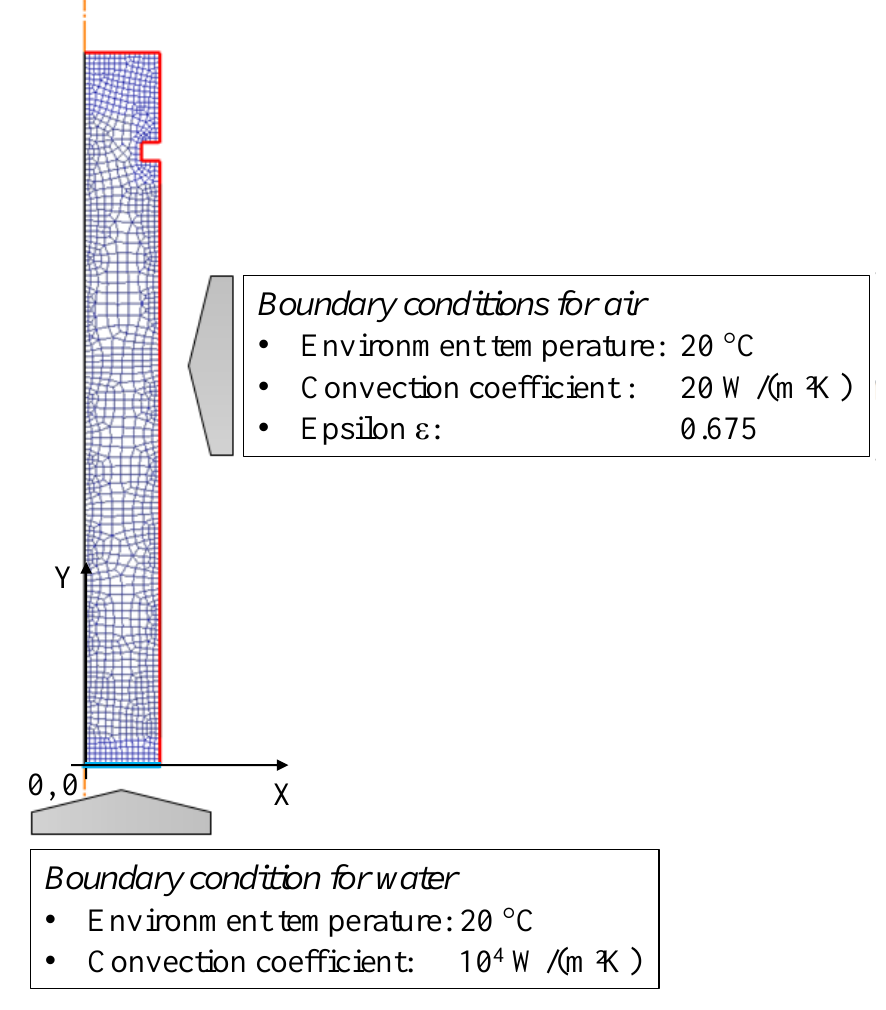
Figure 5. Boundary conditions. Table 3. 2D Mesh parameters used in